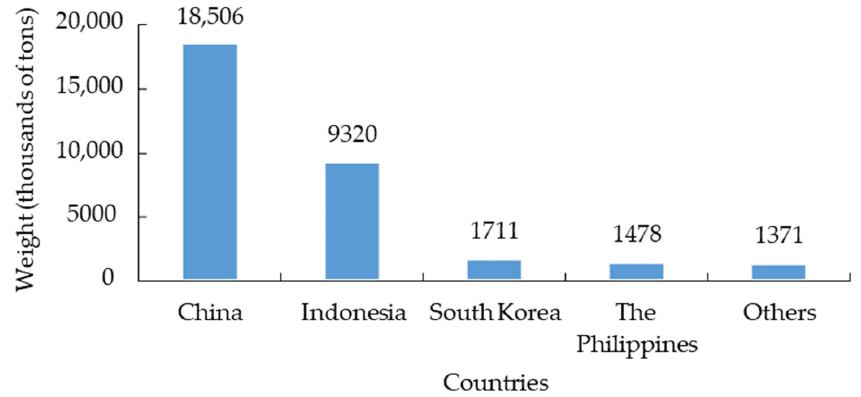
Figure 2. World aquatic algae production in 2018 (thousands of tons, live weight) [31].